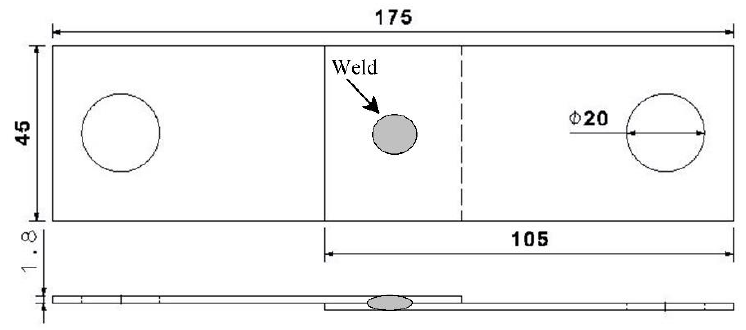
Figure 3. Dimensions of the impact tensile shear test sample (dimensions are in mm).